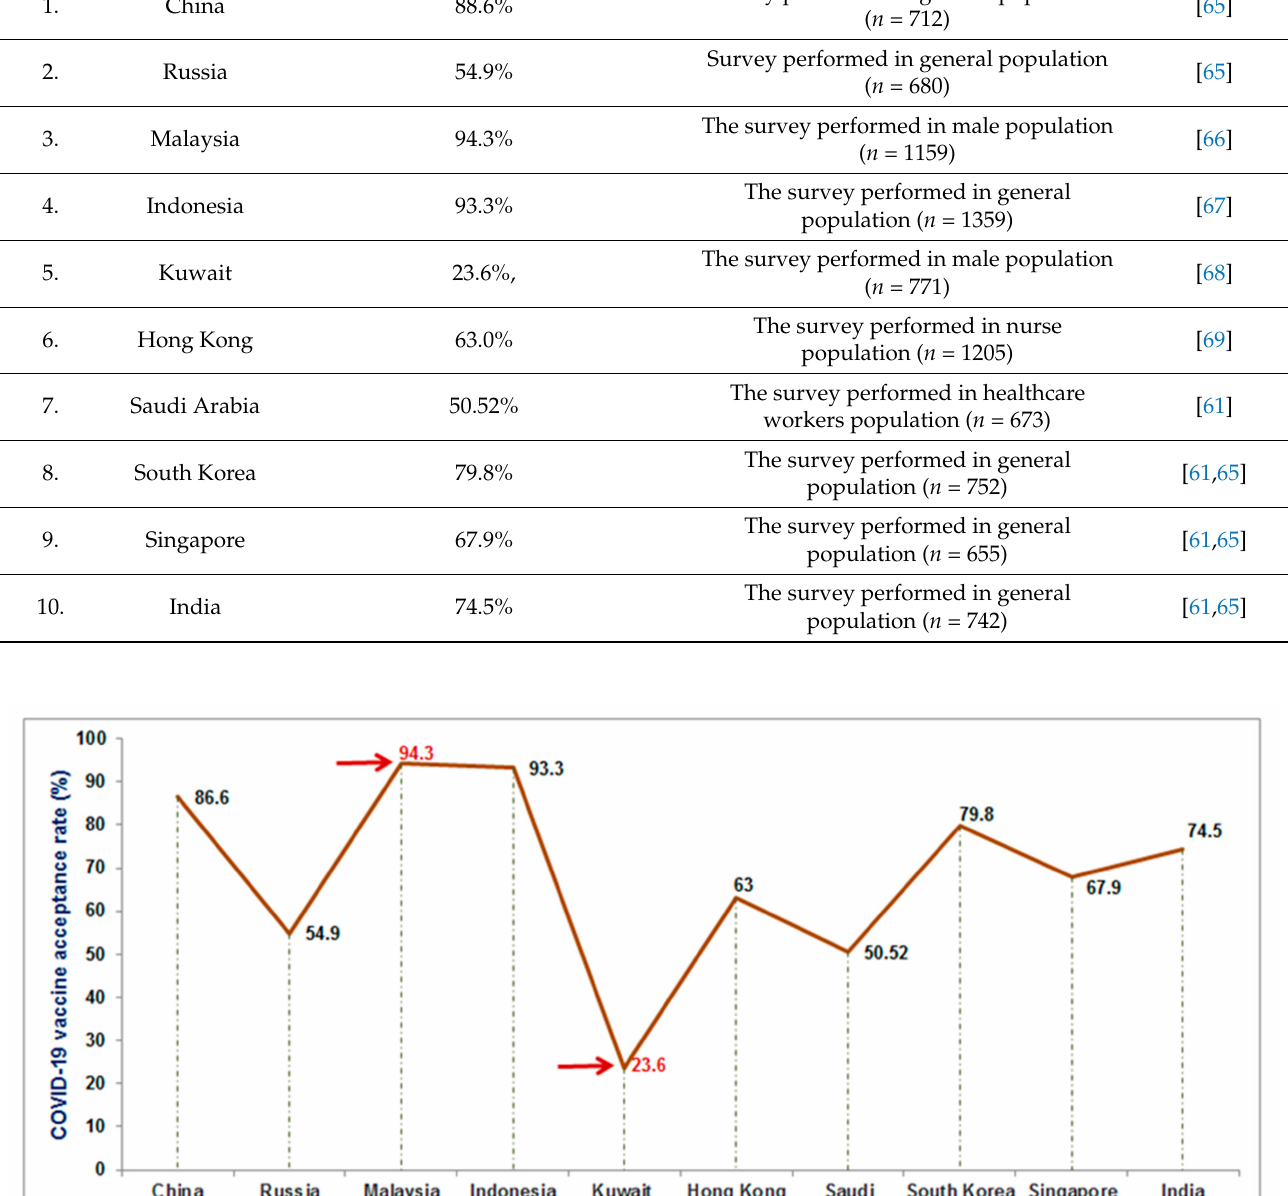
Table 4. COVID-19 vaccine acceptance rate in different Asian countries as observed from various studies. Sl No.